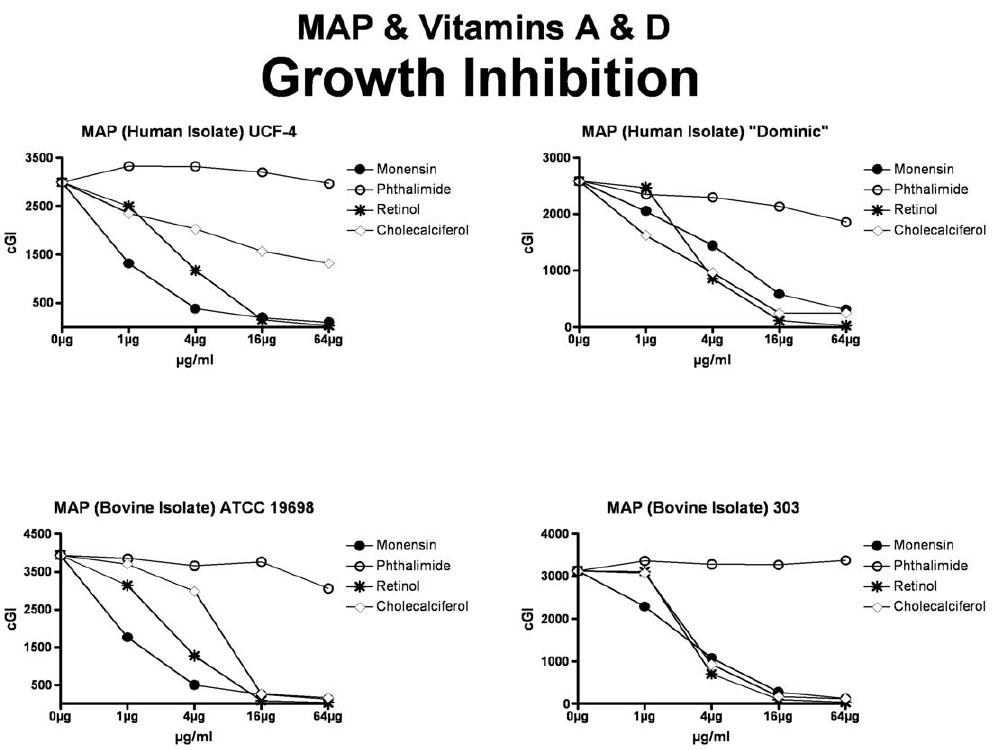
Figure 1. Both vitamins A & D inhibit all four MAP strains studied. Strains from the two upper panels (UCF-4 & Dominic) were isolated from humans with Crohn disease. Strains in the two lower panels were isolated from ruminants with Johne disease. The inhibitory control is Monensin, and the non-inhibitory control is Phthalimide. cGI=cumulative Growth Index.